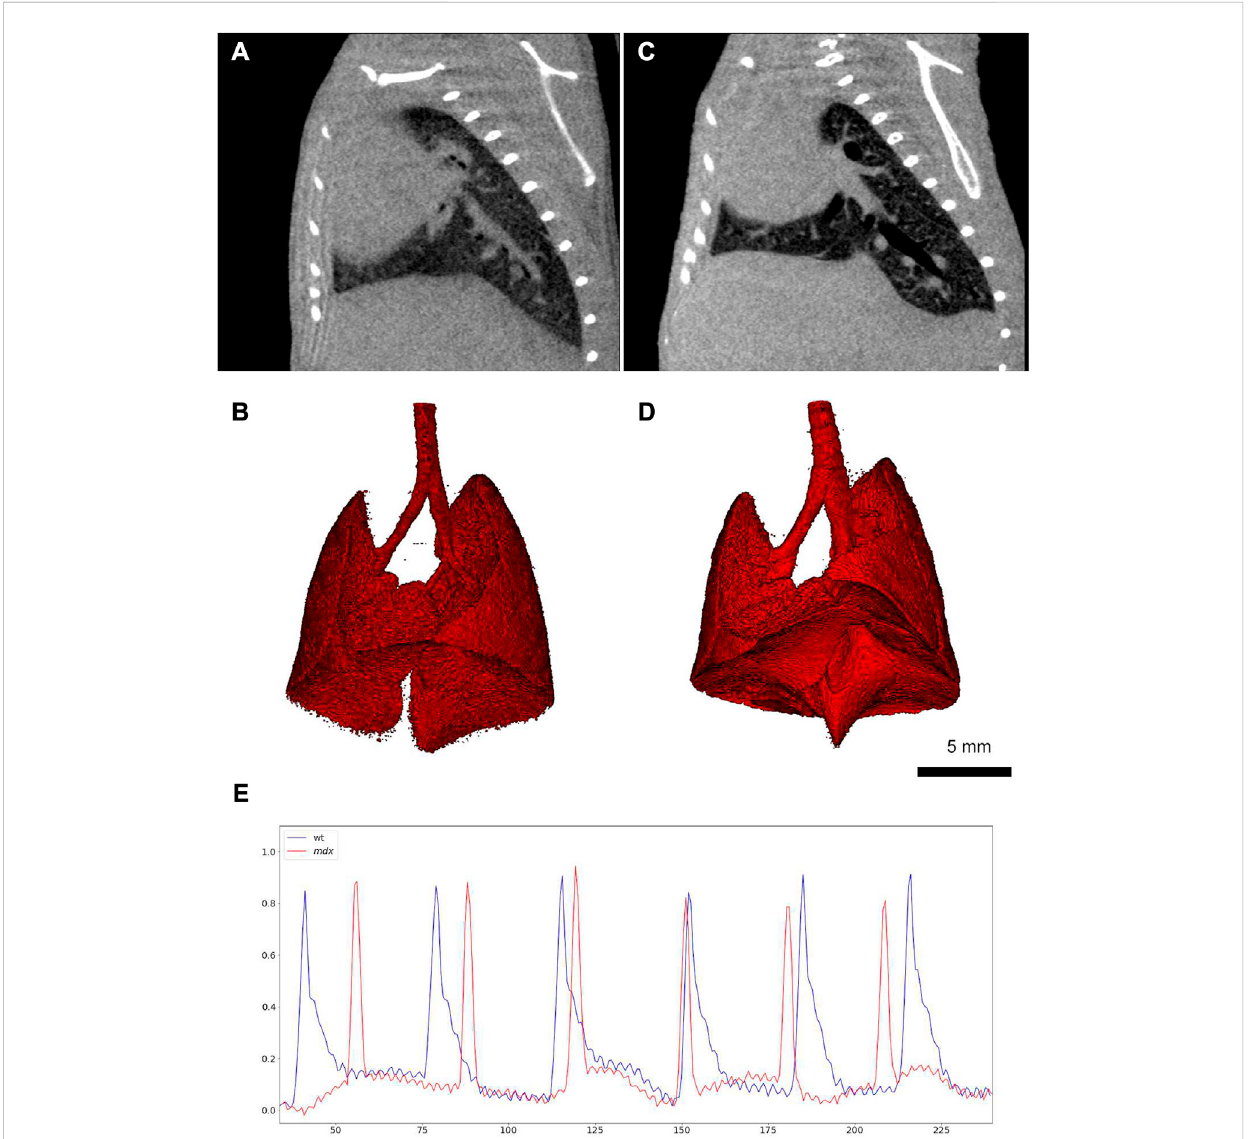
FIGURE 7 Retrospective gating-based x-ray lung function measurement (rgXLF) (A, C) µCT images of a healthy control mouse and a mdx mouse respectively, showingthedifferenceintheshapeofthediaphragms; (B,D) 3Drenderingsofthehealthyandmdxmice; (E) Comparisonofthebreathingpatternsofthe healthyandmdx mice(healthy =blueandmdx=blue),showingamore rapiddecayintheexpirationphaseofthemdxmouse[reprintedfromDullinetal.